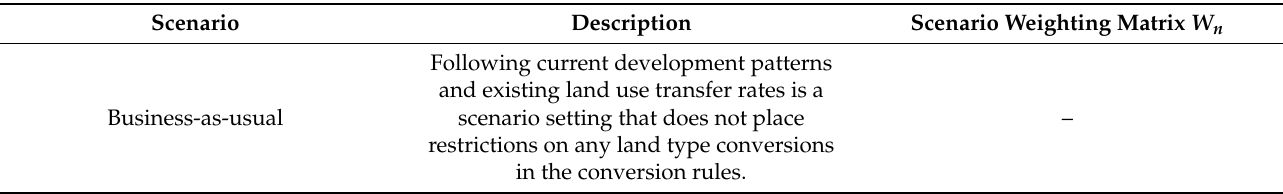
Table 1. Values of the weight matrix W n for different